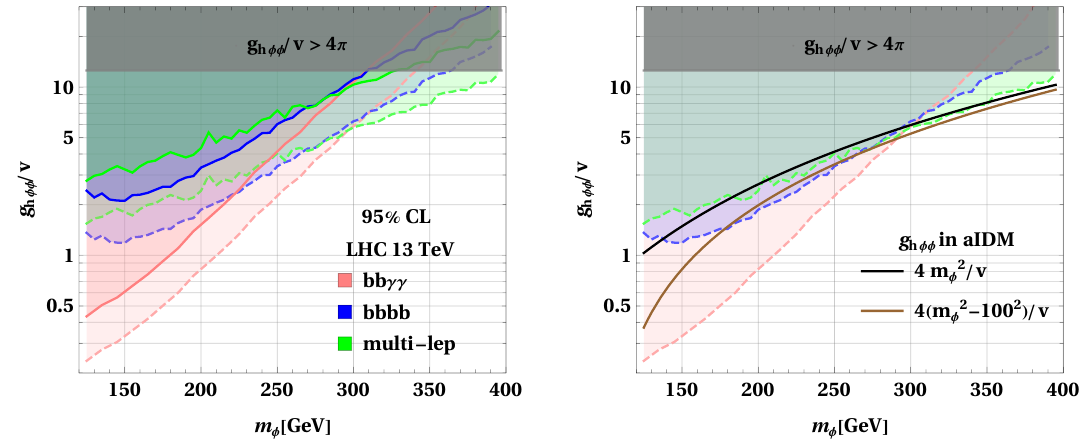
Figure 7. Combined 95% CL upper bounds on g h(cid:30)(cid:30) at 13 TeV LHC. The solid (dashed) curve represents the exclusion limit at 300 fb (cid:0) 1 (3000 fb (cid:0) 1 ). Examples of g h(cid:30)(cid:30) values expected from the almost inert doublet model are plotted in the right